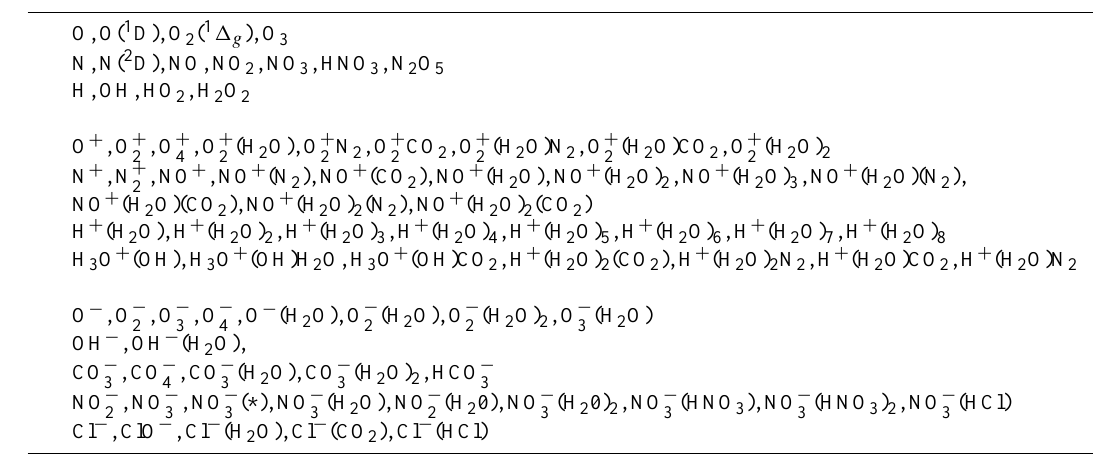
Table 1. SIC model: modelled ions and minor neutral